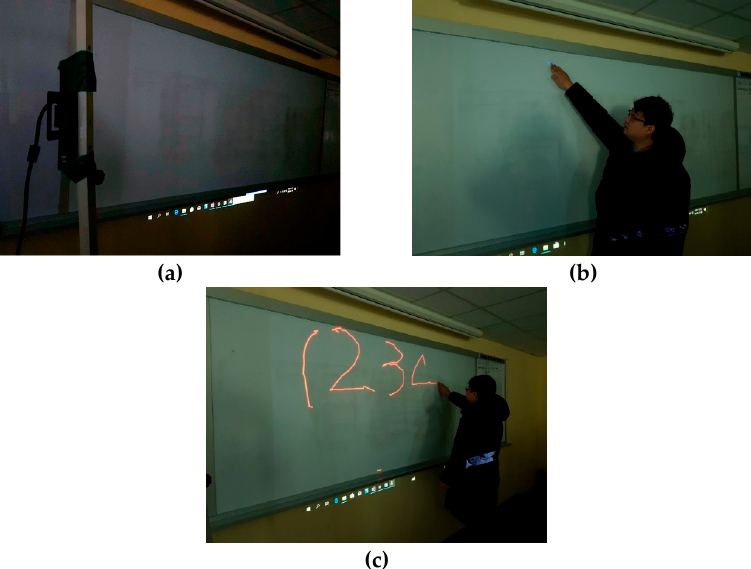
Figure 13. Implementation of touch-pen using virtual touch sensor: ( a ) placing depth camera; ( b ) calibration of virtual touch sensor; ( c ) implementation of touch-pen.